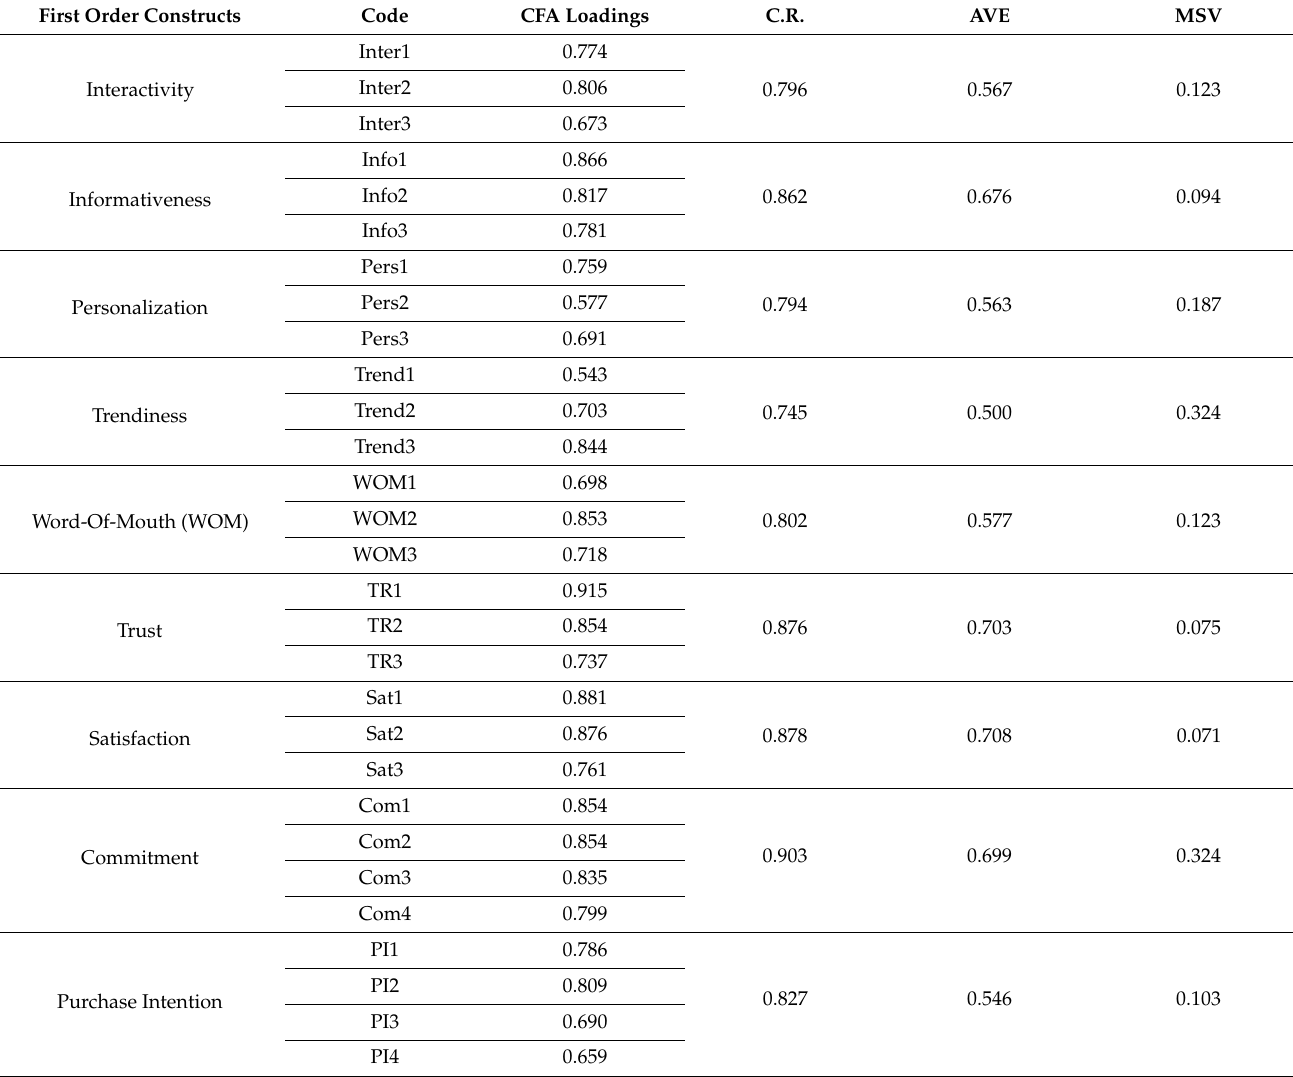
Table 2. Loadings of Confirmatory factor analysis (CFA) First Order.